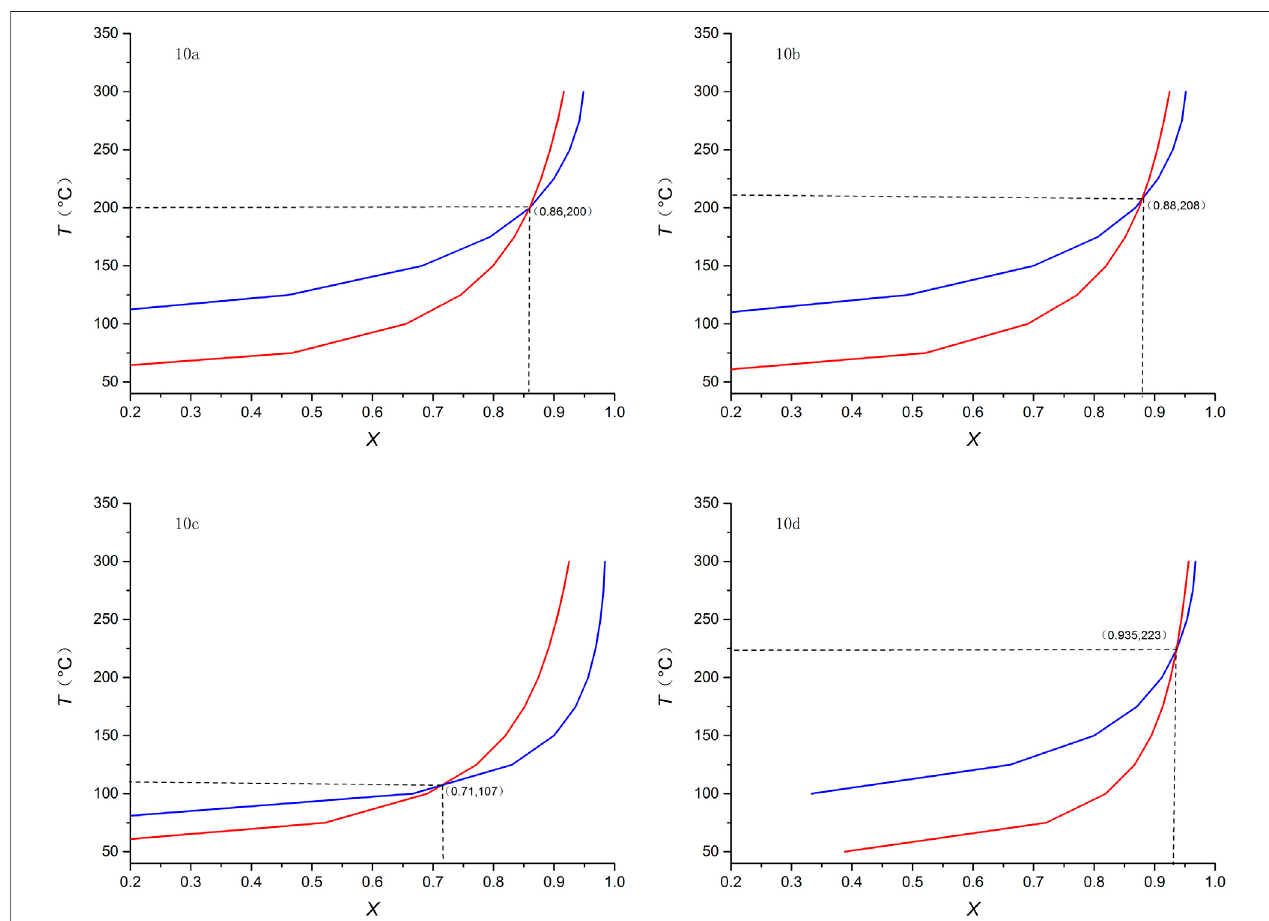
FIGURE 6 | A diagram of temperature relative to the proportion of cold water in hot spring sample 10 ( X is the proportion of the cold water).